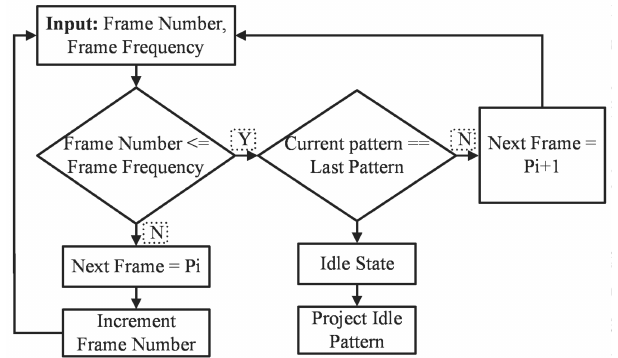
Figure 7. Block diagram of adaptive frame rate projection controller module in